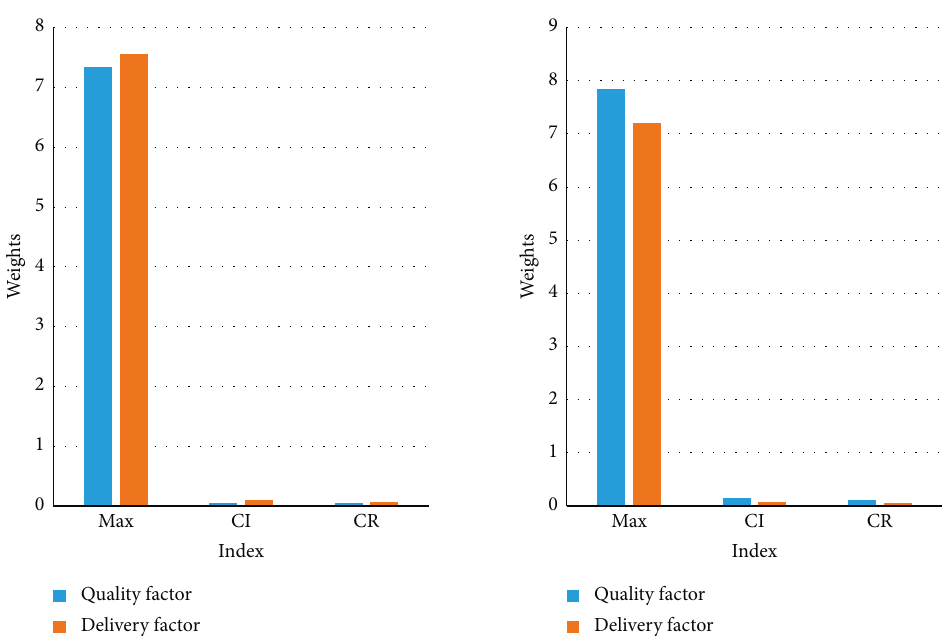
Figure 10: CR values for supplier evaluation